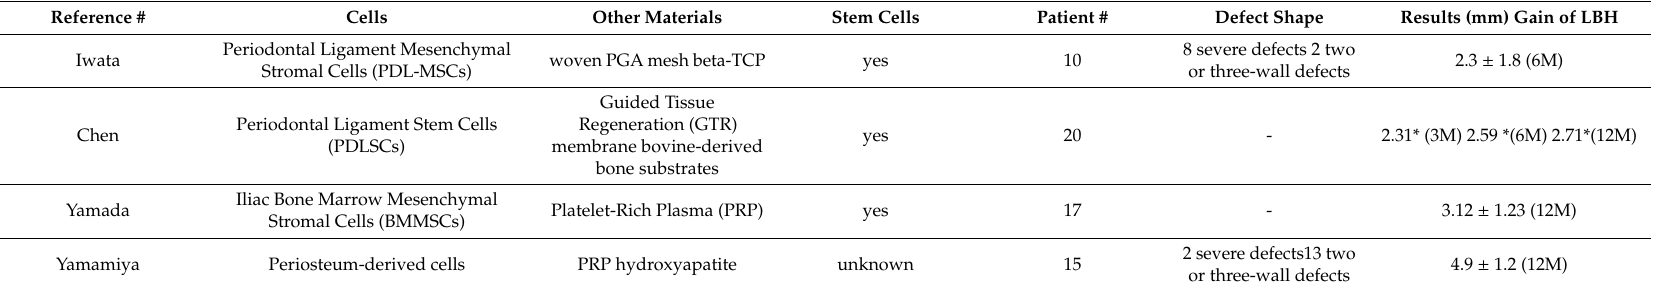
Table 1. Ex vivo expanded stem / progenitor cell transplantation studies for periodontal regeneration in clinical